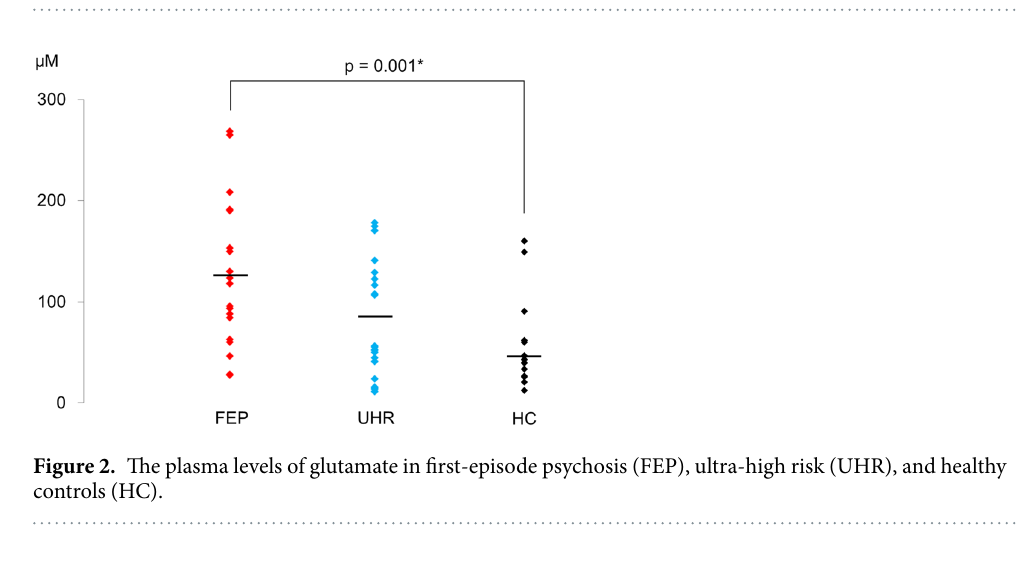
Figure 1. Grand average waveforms of duration mismatch negativity (dMMN) (left) and frequency mismatch negativity (fMMN) (right) at the electrode FCz in first-episode psychosis (FEP; red line), ultra-high risk (UHR; blue line), and healthy controls (HC; black line).